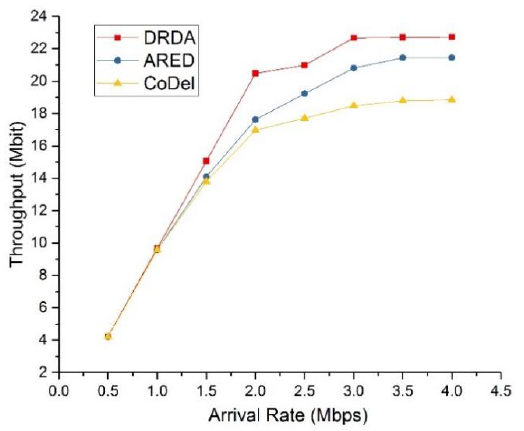
Figure 6. Throughput of DRDA compared with that of ARED and CoDel.